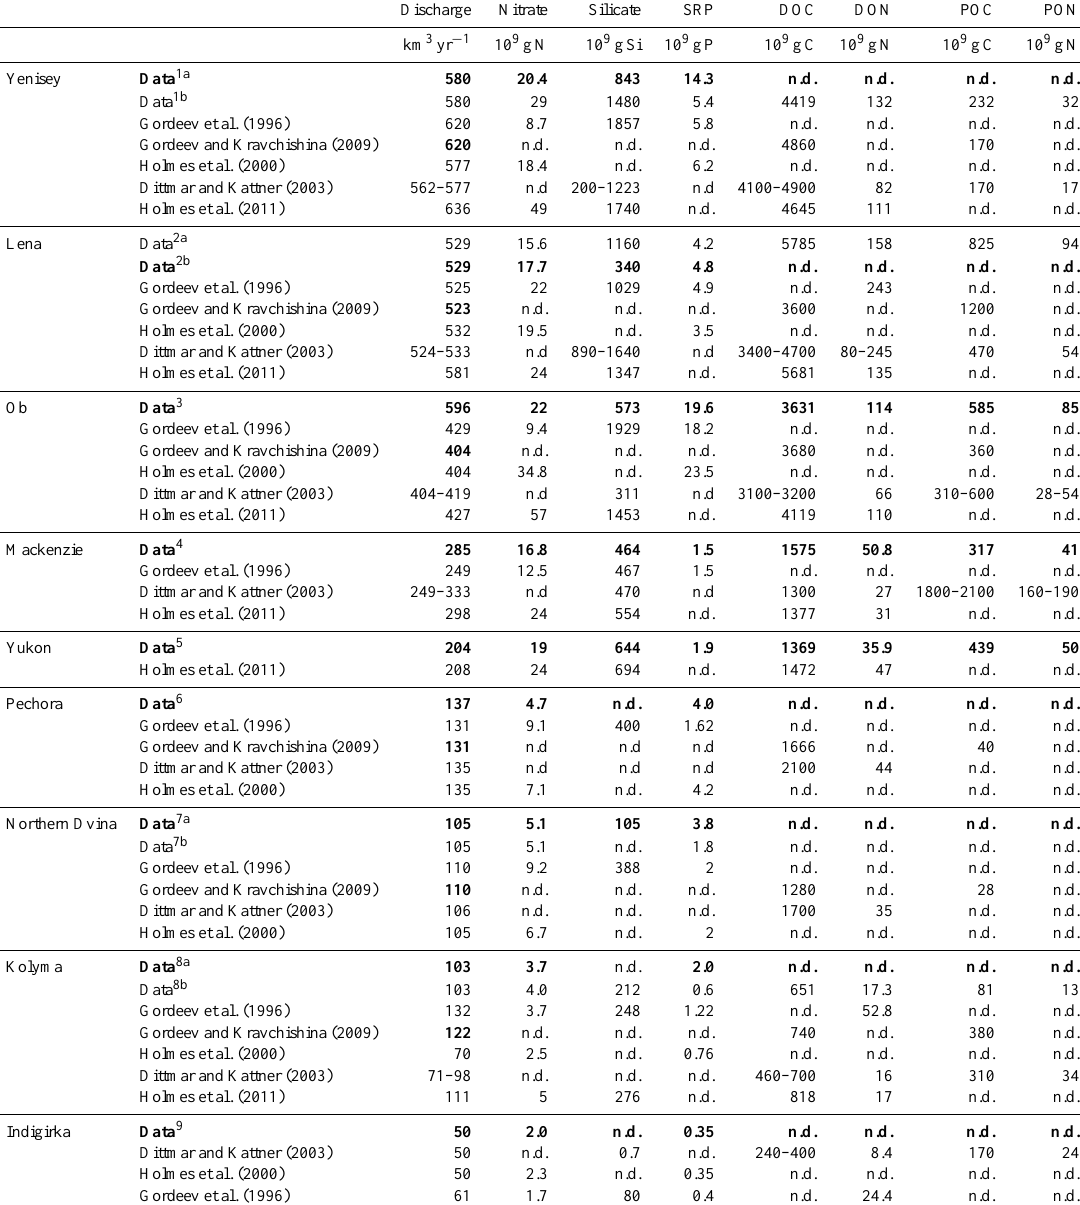
Table 2. Annual discharge of freshwater, dissolved inorganic nutrients (nitrate, silicate and SRP), and dissolved and particulate organic carbon (DOC and POC, respectively) and nitrogen (DON and PON, respectively) for 9 rivers entering the Arctic Ocean. Flux estimates calculated from the discharge and nutrients measured at the same river sampling location are in bold. n.d. indicates no data